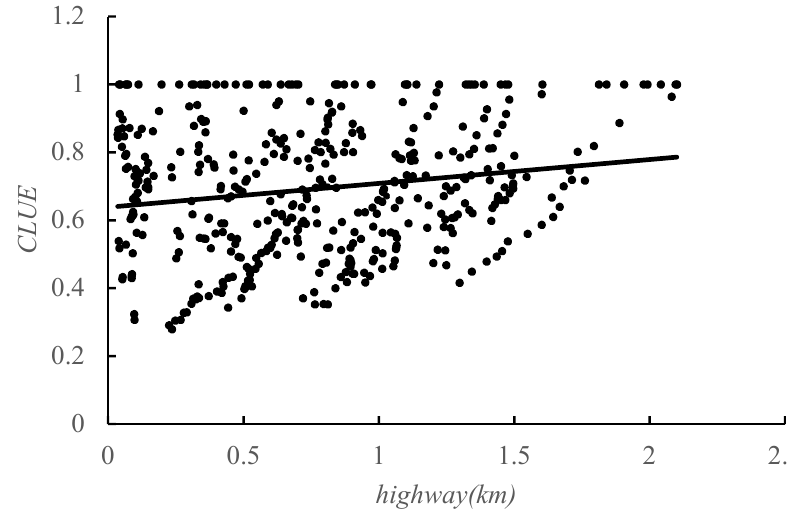
Figure 4. Scatter diagram of the linear fitting between highway density and CLUE.